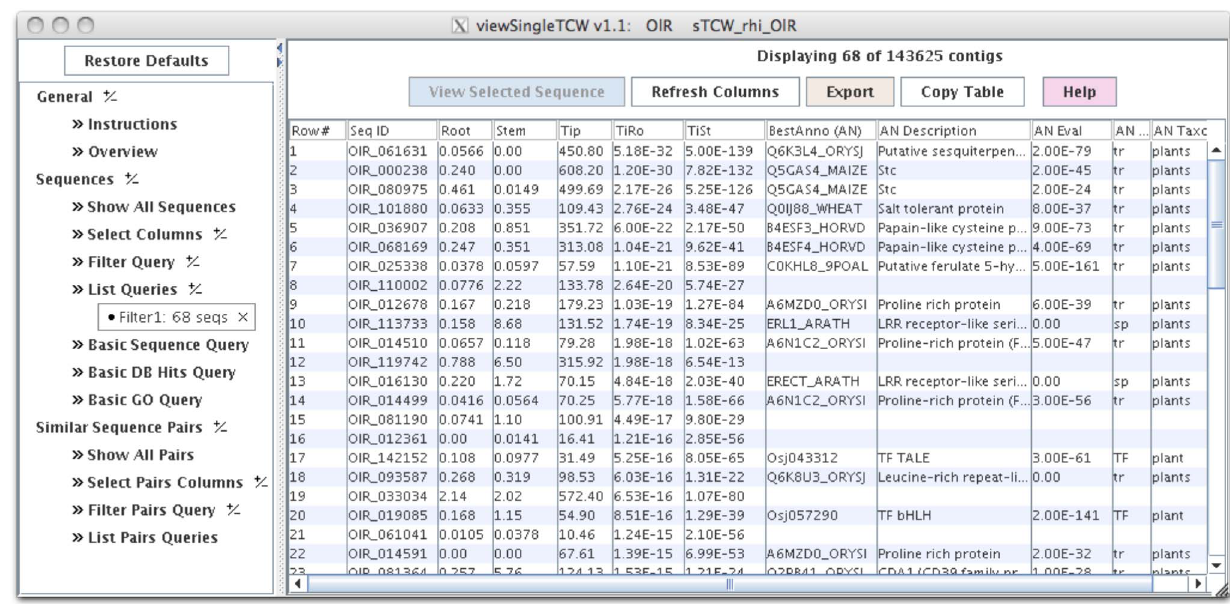
Figure 3. The viewSingleTCW interface. This shows the main table, where the filter was set to show all sequences where tip is differentially expressed compared to root and stem using a 1E-10 cutoff. The columns are: Root, Stem and Tip are the RPKM values; TiRo and TiSt are DE p-values between tip-root and tip-stem, respectively; BestAnno (AN) is the best annotation for the sequence (i.e. not containing phrases such as ‘‘uncharacterized protein’’); and the last four columns are the BestAnno description, BLAST e-value, the DB type (‘tr’=TrEMBL, ‘sp’=Swiss-Prot, ‘TF’=plantTFDB), and the taxonomic type (all these best hits are from plants).